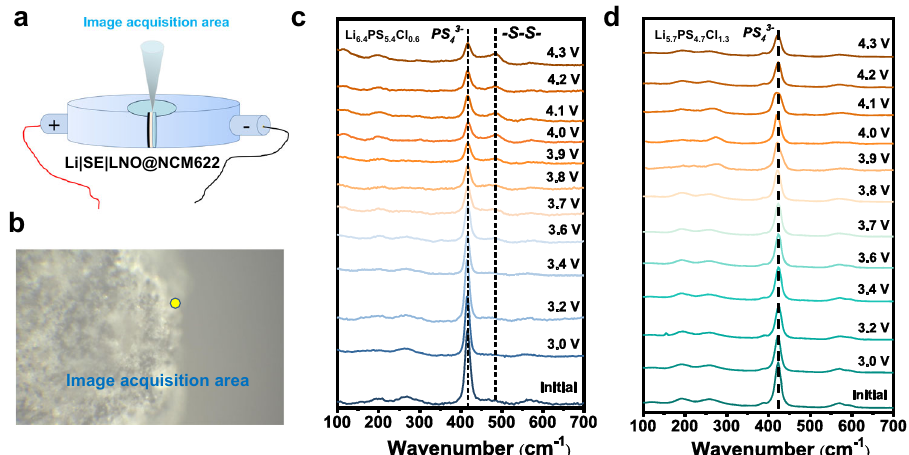
Fig. 10 In situ Raman spectroscopy detection at the Li|SE interface region on Li|SE|LNO@NCM622 cells with Cl-06 and Cl-13 SEs. a Drawing of the in situ Raman mold. b Image of laser focusing area on the Li|SE interface. In situ Raman spectra of Cl-06 ( c ) and Cl-13 ( d ) in charging process run under 0.1 mA/cm 2 at 24